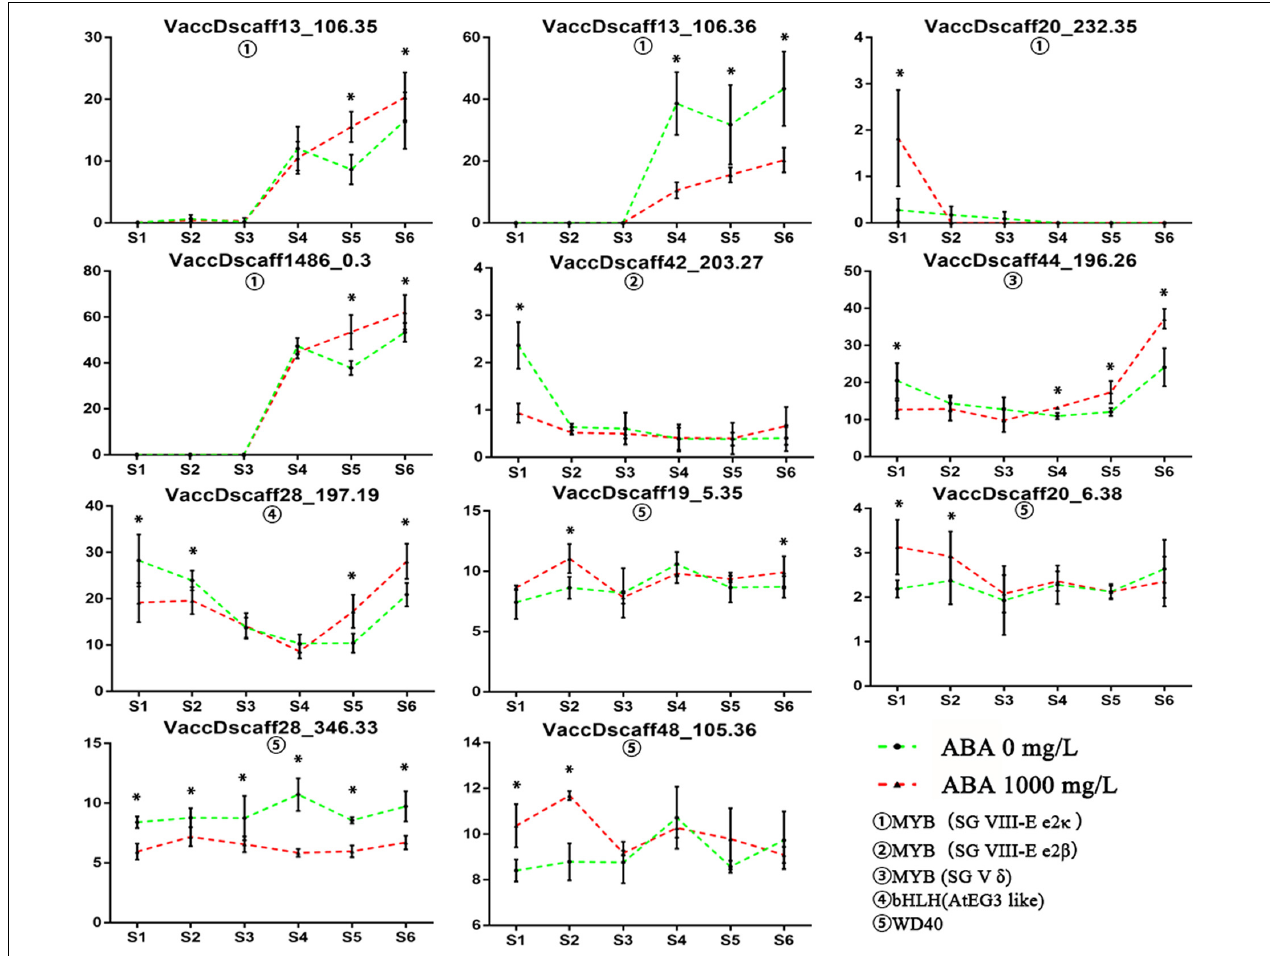
FIGURE 6 | MYB, bHLH, and WD40 transcription factors with different expression in S1–S6. FPKM is used to represent the level of gene expression. Asterisk indicates statistical significance ( P < 0.05) as determined by a one-way ANOVA test (Duncan’s multiple range). Values represent the means ± SD of three